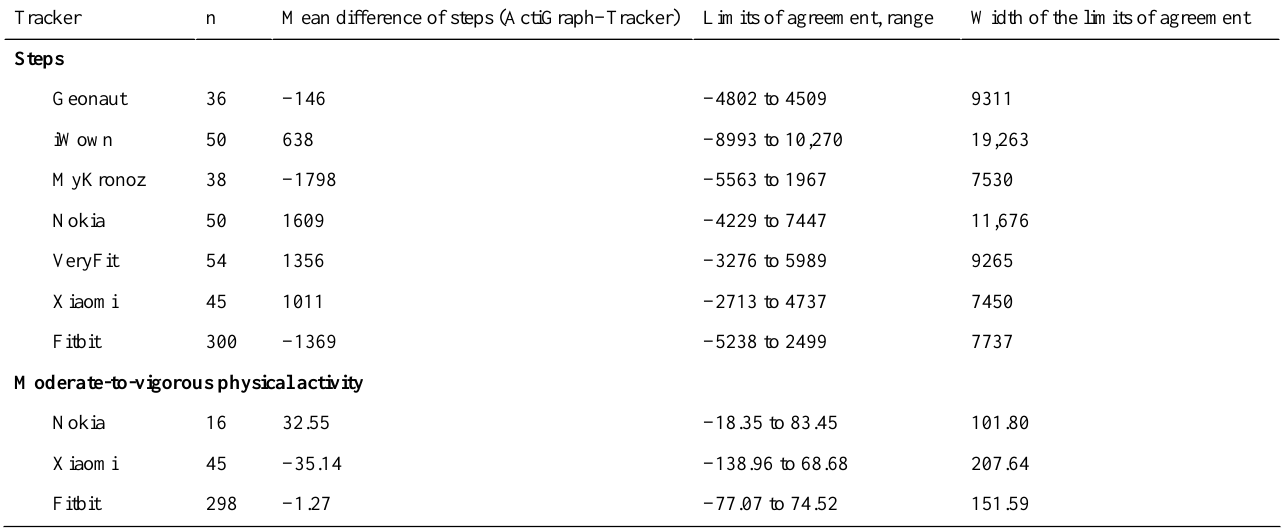
Table 3. Mean differences of activity measures with the ActiGraph accelerometer and limits of agreement of the activity